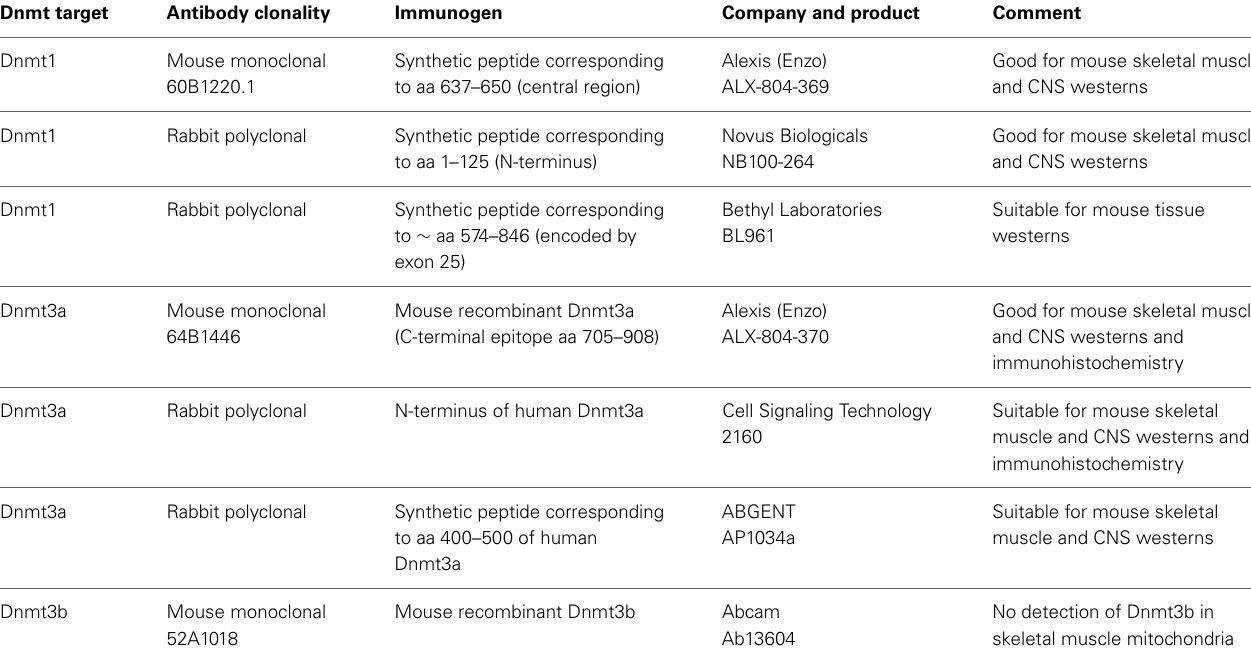
Table 1 | Antibodies to Dnmt isoforms screened in this